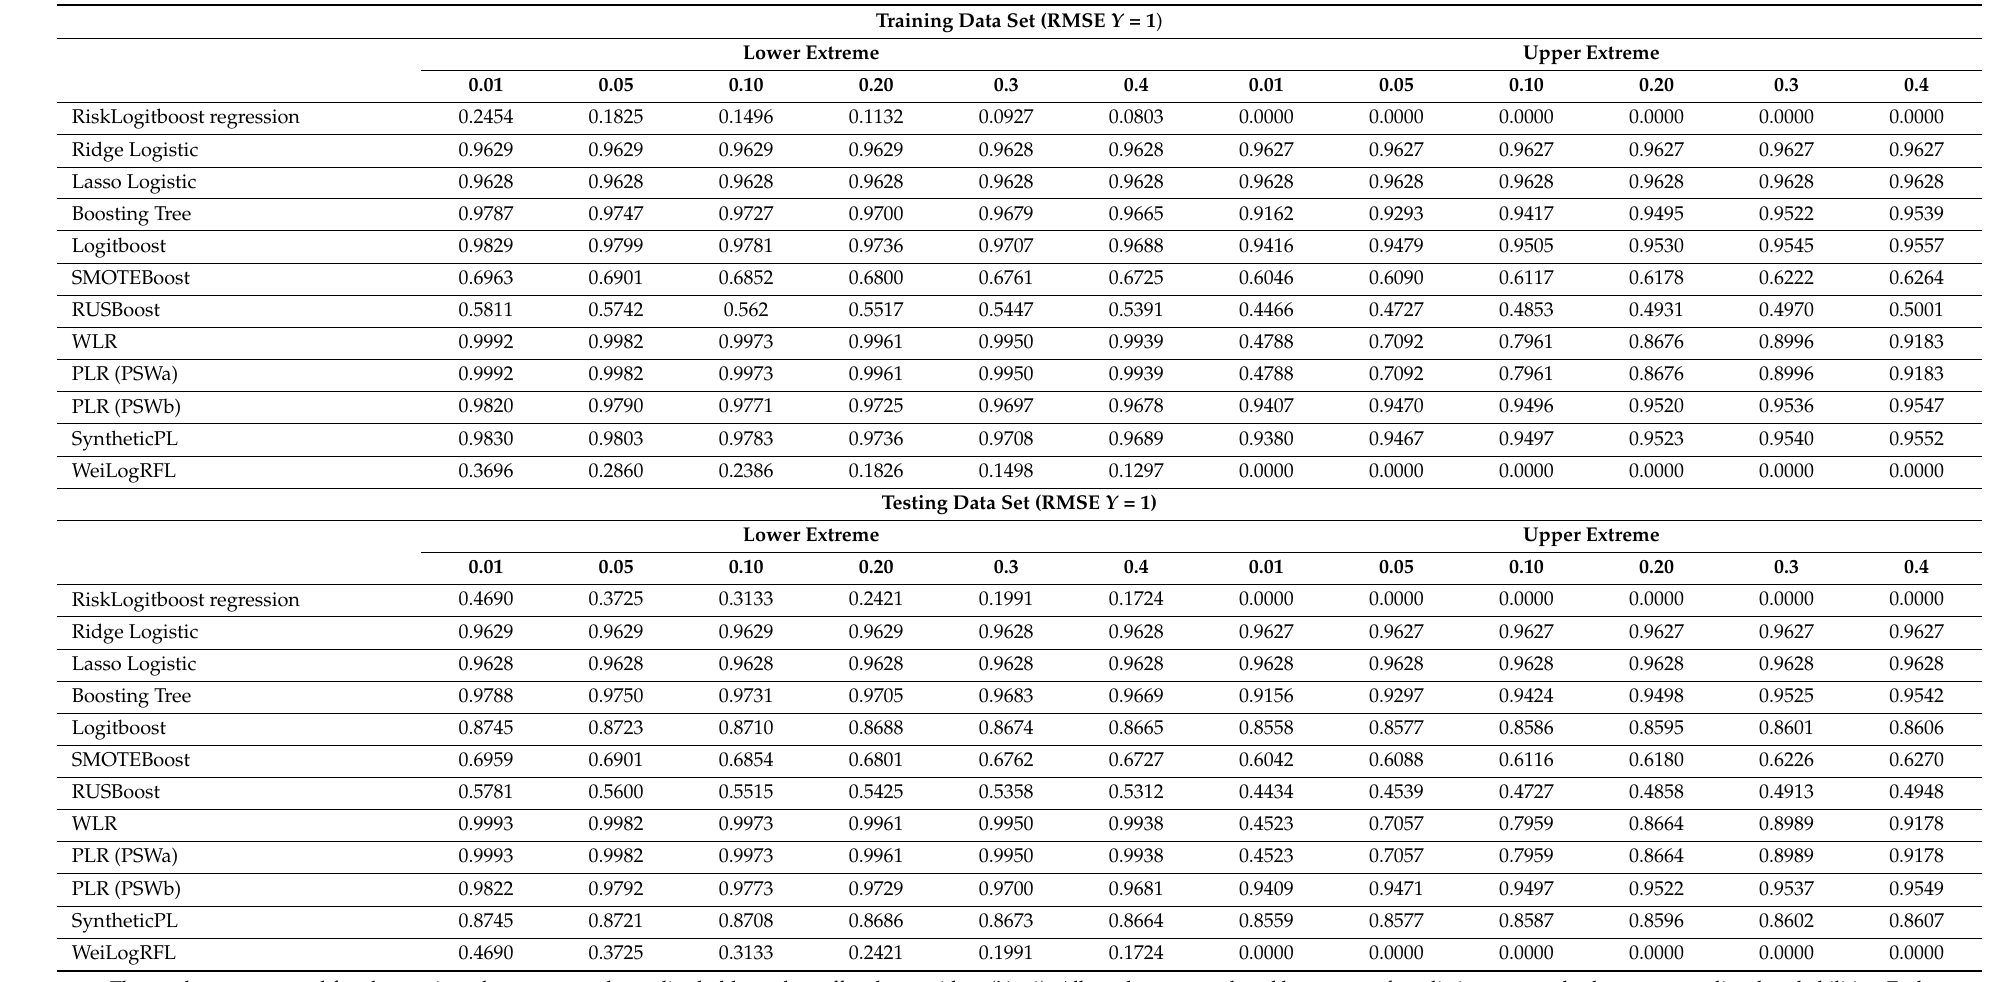
Table 1. Root Mean Square Error (RMSE) for observations with Y =